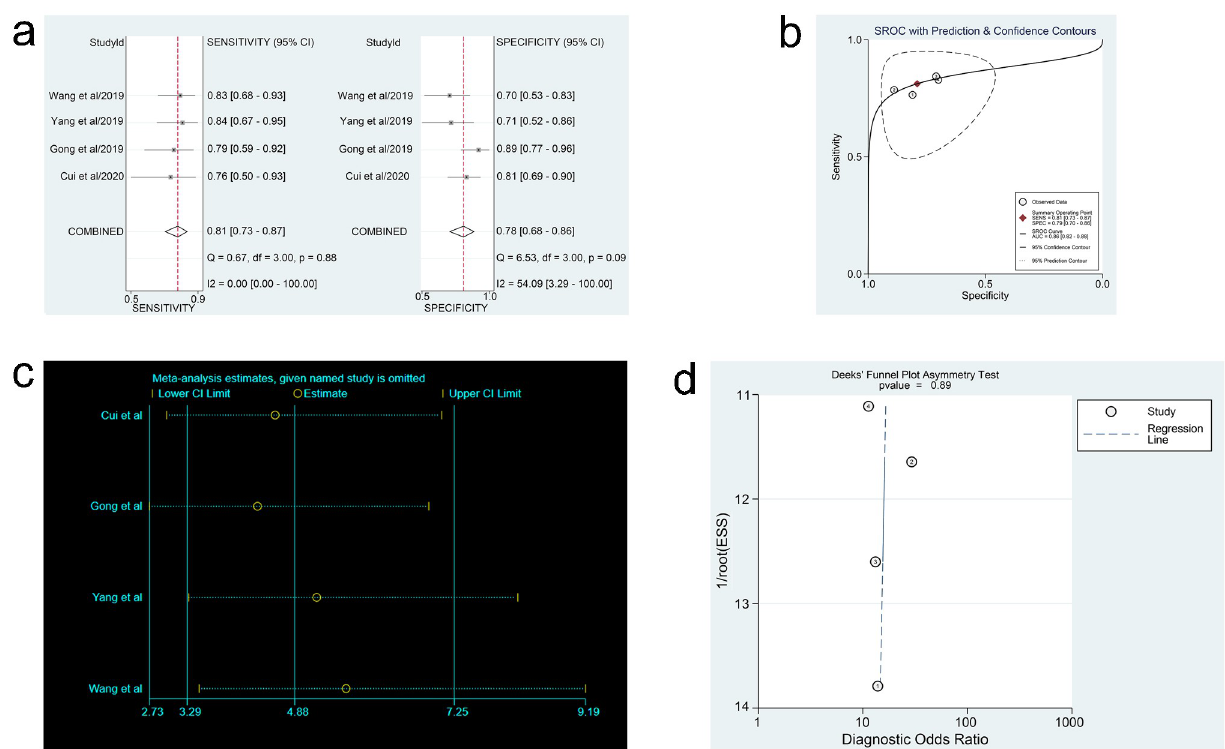
Fig 4. Forest plots of sensitivity and specificity, SROC curve, sensitivity analysis plot and Deeks’ funnel plot of lncRNAs. (a) Forest plots of sensitivity and specificity to evaluate the diagnostic performance of lncRNAs. (b) SROC curve to describe the diagnostic value of lncRNAs. (c) Sensitivity analysis to estimate each study’s value of lncRNAs. (d) Deeks’ funnel plot to assess publication bias of lncRNAs.